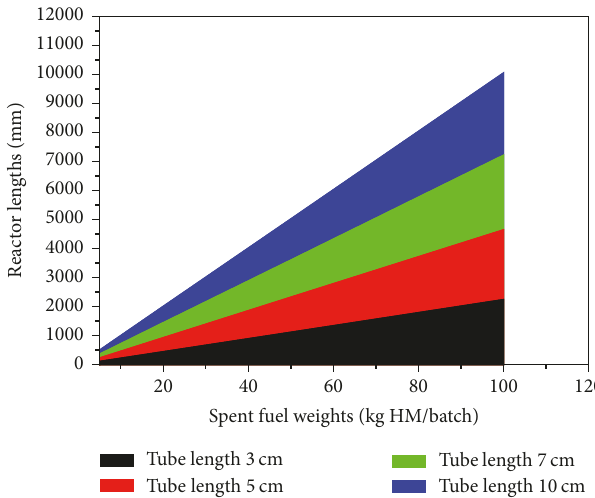
Figure 10: Reactor length for various hull lengths as a function of spent fuel weight.